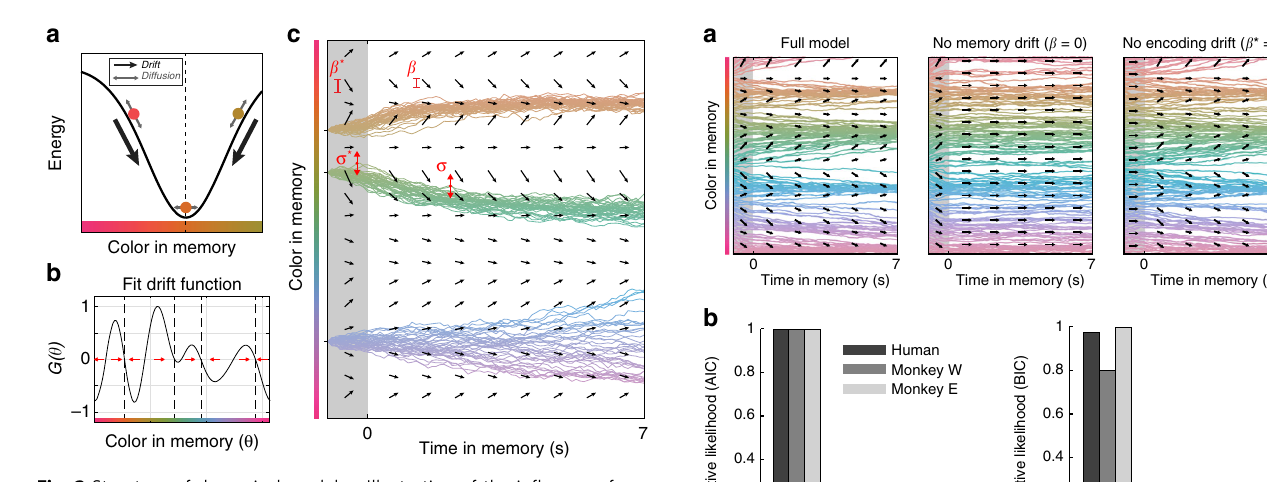
Fig. 2 Structure of dynamical model. a Illustration of the in fl uence of attractors on color memory. Attractors (dashed line) cause memories to drift over time (black arrow), introducing bias in reports. Noise causes memories to randomly diffuse (grey arrows). b The drift function G ( θ ) describes how a memory will change based on its current state. Red arrows show the direction of drift; attractors have converging drift (dashed lines). We estimated G ( θ ) for each subject using a linear combination of von mises derivatives. c The simulated evolution of three color memories during a hypothetical trial. Memory evolves over time according to the drift function (vector fi eld) and random noise. Each line indicates the temporal evolution of a remembered color under a different realization of the noise process. Terms described in main text. Source data are provided as a uniform 23 – 26 (Fig. 1c, humans and monkeys p < 0.001 against uniformity, Hodges-Ajne test; p < 0.001 against target distribu- tion, permuted Kuipers test). This was re fl ected in a signi fi cant decrease in the entropy of the response distribution relative to the target distribution (H: 2.54 vs. 2.61 bits, t (89) = 13.90, p < 1 × 10 − 15 , t test; W: 2.61 vs. 2.65 bits, p < 0.001, bootstrap; E: 2.58 vs. 2.65 bits, p < 0.001, bootstrap). Responses clustered around speci fi c colors, seen as peaks in the response histogram (Fig. 1c). Clustering increased with delay time ( F (1, 89) = 9.56, p = 0.003,